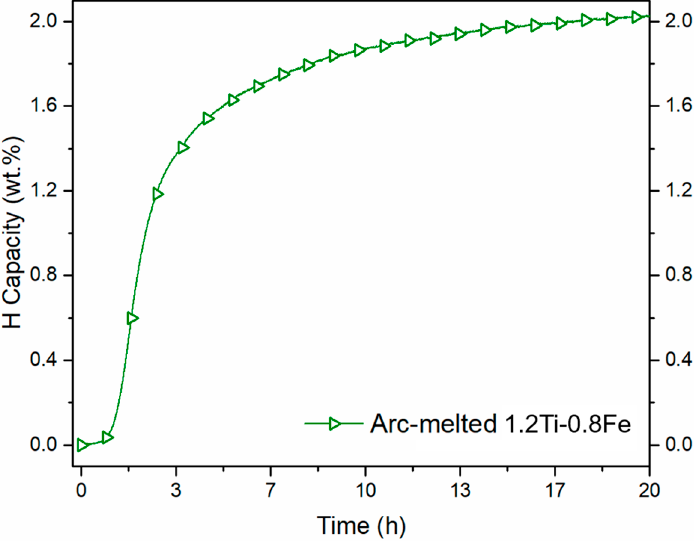
Figure 6. Activation curve of the arc-melted 1.2Ti–0.8Fe.